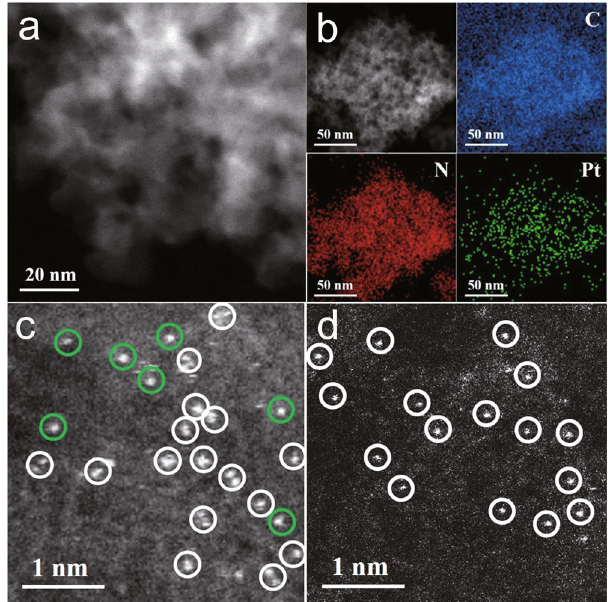
Fig. 1 Characterization of Pt 2 /mpg-C 3 N 4 sample. a HAADF-STEM image of Pt 2 /mpg-C 3 N 4 . b EDX mapping distributions of the C (blue), N (red), and Pt (green) elements, respectively. c , d AC HAADF-STEM images of the Pt 2 /mpg-C 3 N 4 and Pt 1 /mpg-C 3 N 4 samples,